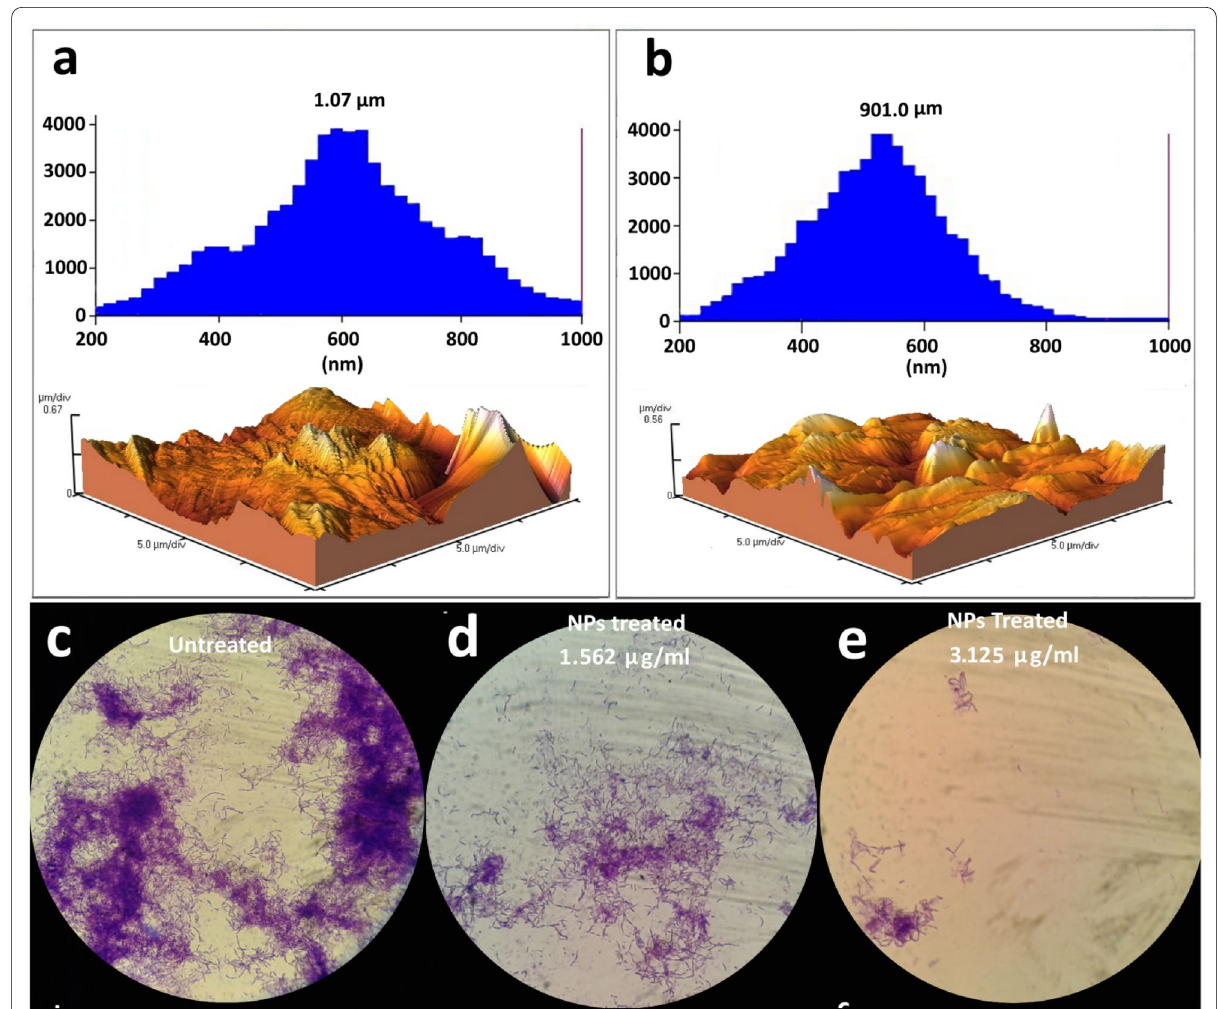
Fig. 6 Atomic force microscopy of P. aeruginosa biofilm a untreated and b treated with Ag 2 Se-NCs. Comparative light microscopic images of P. aeruginosa biofilm among c untreated, d treated with 1.56 µg/ml of Ag 2 Se-NCs and e treated with 3.125 µg/ml of Ag 2